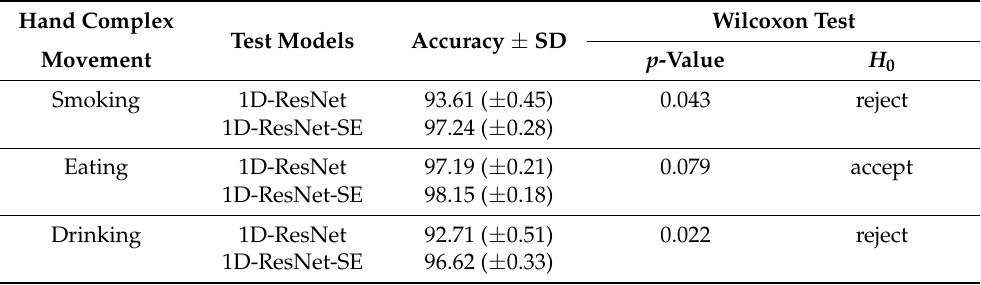
Table 8. Wilcoxon test based on the accuracy metrics for model performance comparison on the UT-Smoke dataset.